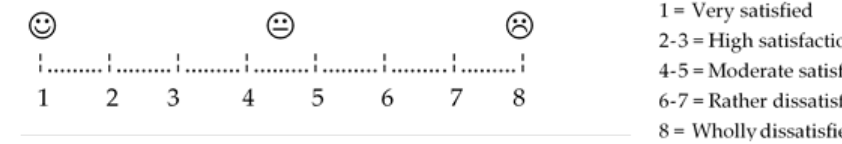
Figure 2. Likert-type scale with 5 score ranges. Satisfaction Scale.